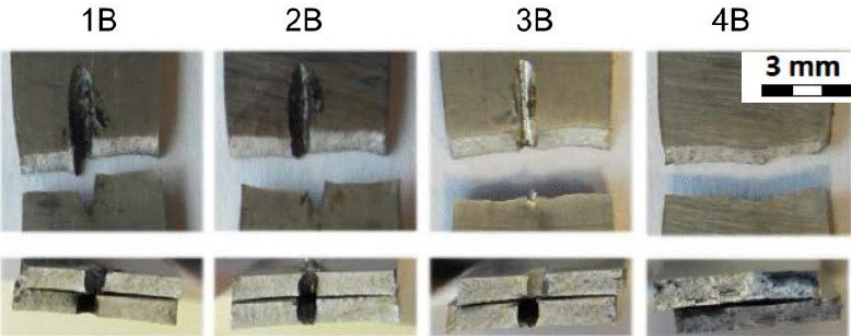
Figure 12. Fracture areas and fracture surfaces of individual sample groups—material thickness 1.0 mm; tests at room temperature.